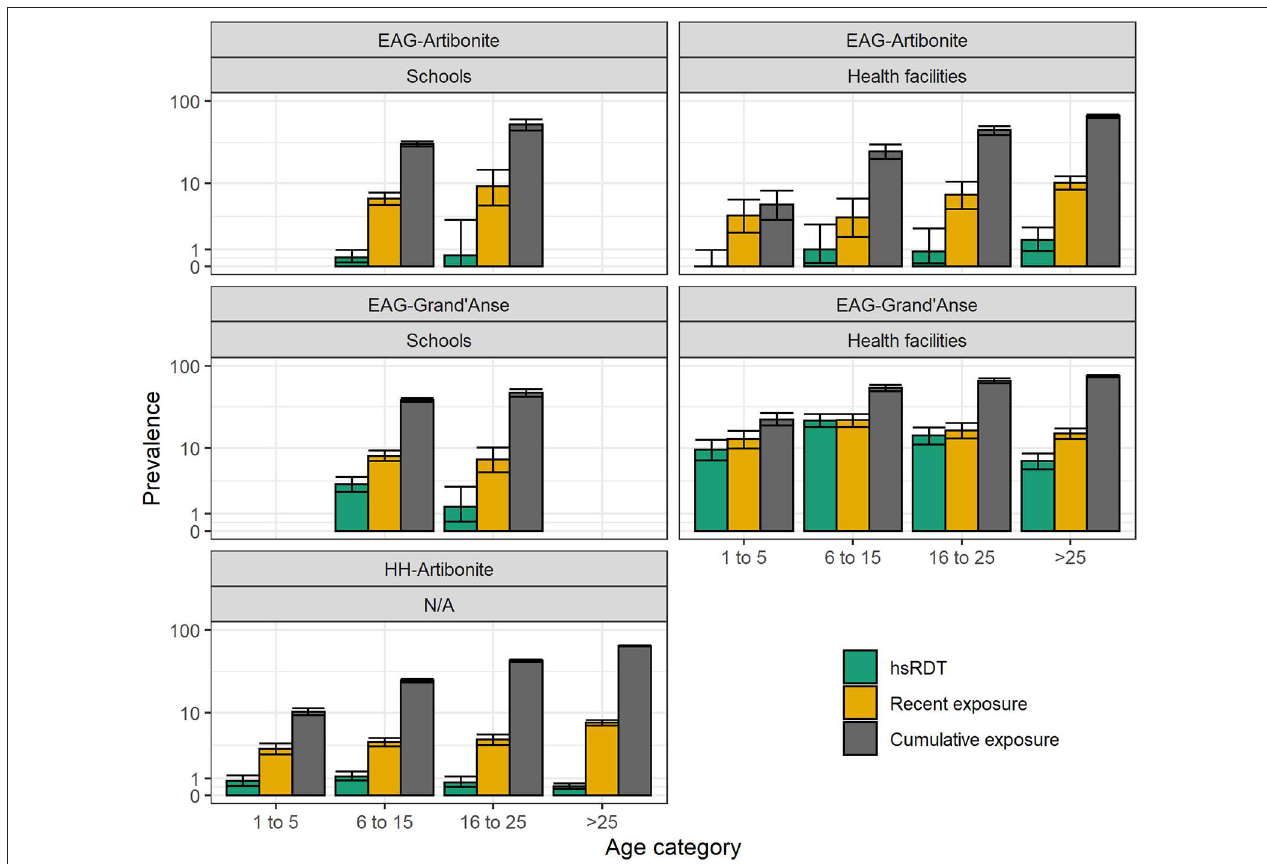
FIGURE 4 | Highly sensitive rapid diagnostic test (hsRDT) prevalence as well as recent and cumulative exposure seroprevalence per age category (in years) and survey in Haiti. Recent exposure represents seropositivity to early transcribed membrane protein 5 (Etramp 5 ag 1) while cumulative exposure represents seropositivity to apical membrane antigen 1 (AMA-1) and/or the 19 kDa fragment of merozoite surface protein 1 (MSP-1 19